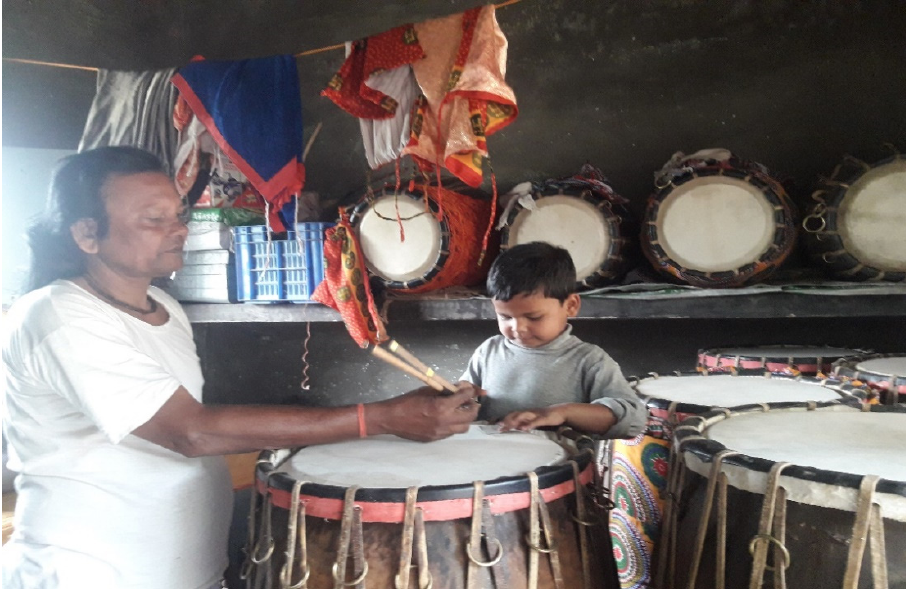
Figure 2. A dhaki and his grandson with dhaks in their home in